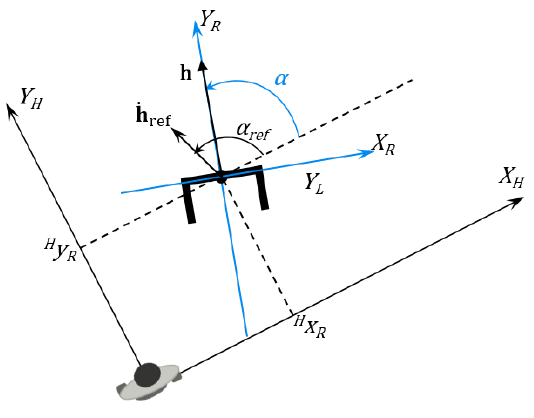
Figure 16. Robot position projected into the human